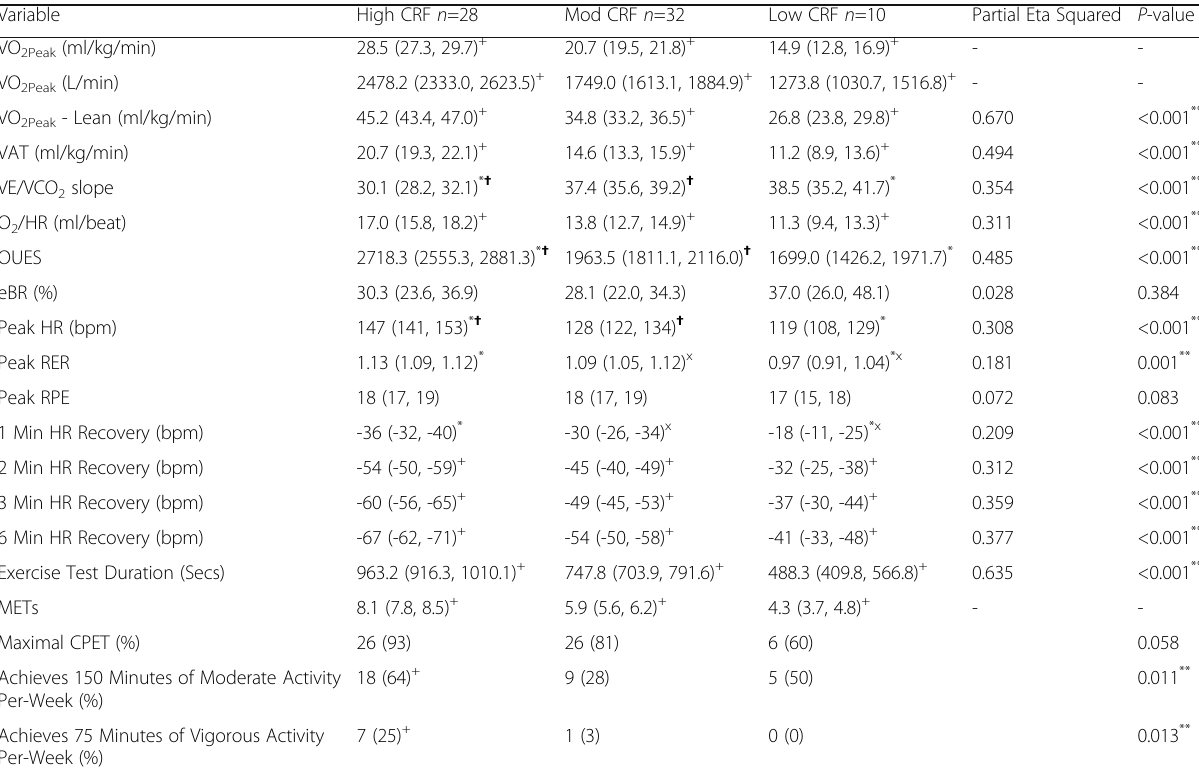
Table 4 Cardiorespiratory fitness and physical activity characteristics expressed as mean (95% confidence